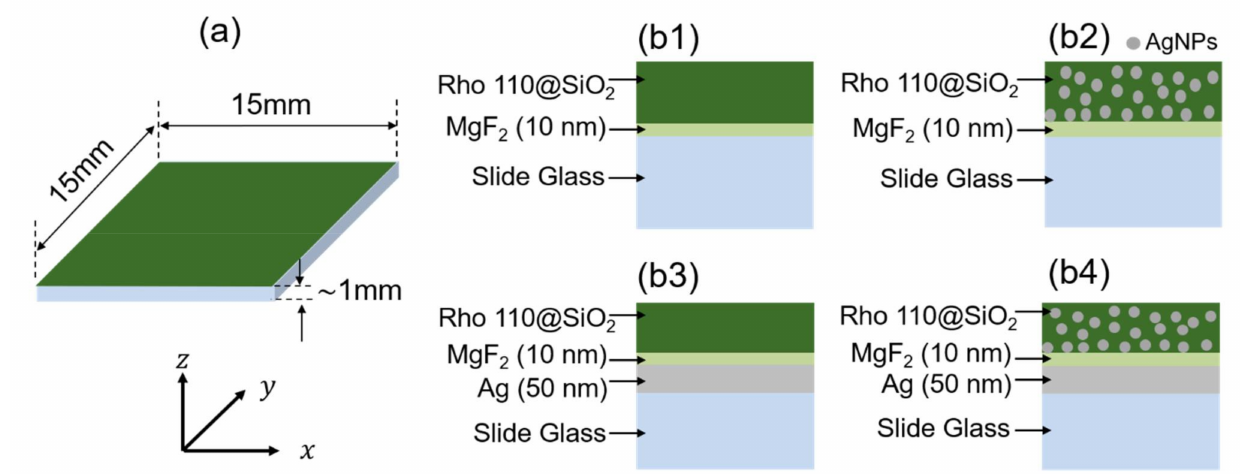
Figure 1. ( a ) The chip dimension; ( b1 – b4 ) schematic of the side views of the four different fluorescence chips used for fluorescence detection. Rho 110@SiO 2 represents the rhodamine 110 molecules dispersed within a SiO 2 layer. The structure in ( b1 ) is used for control fluorescence